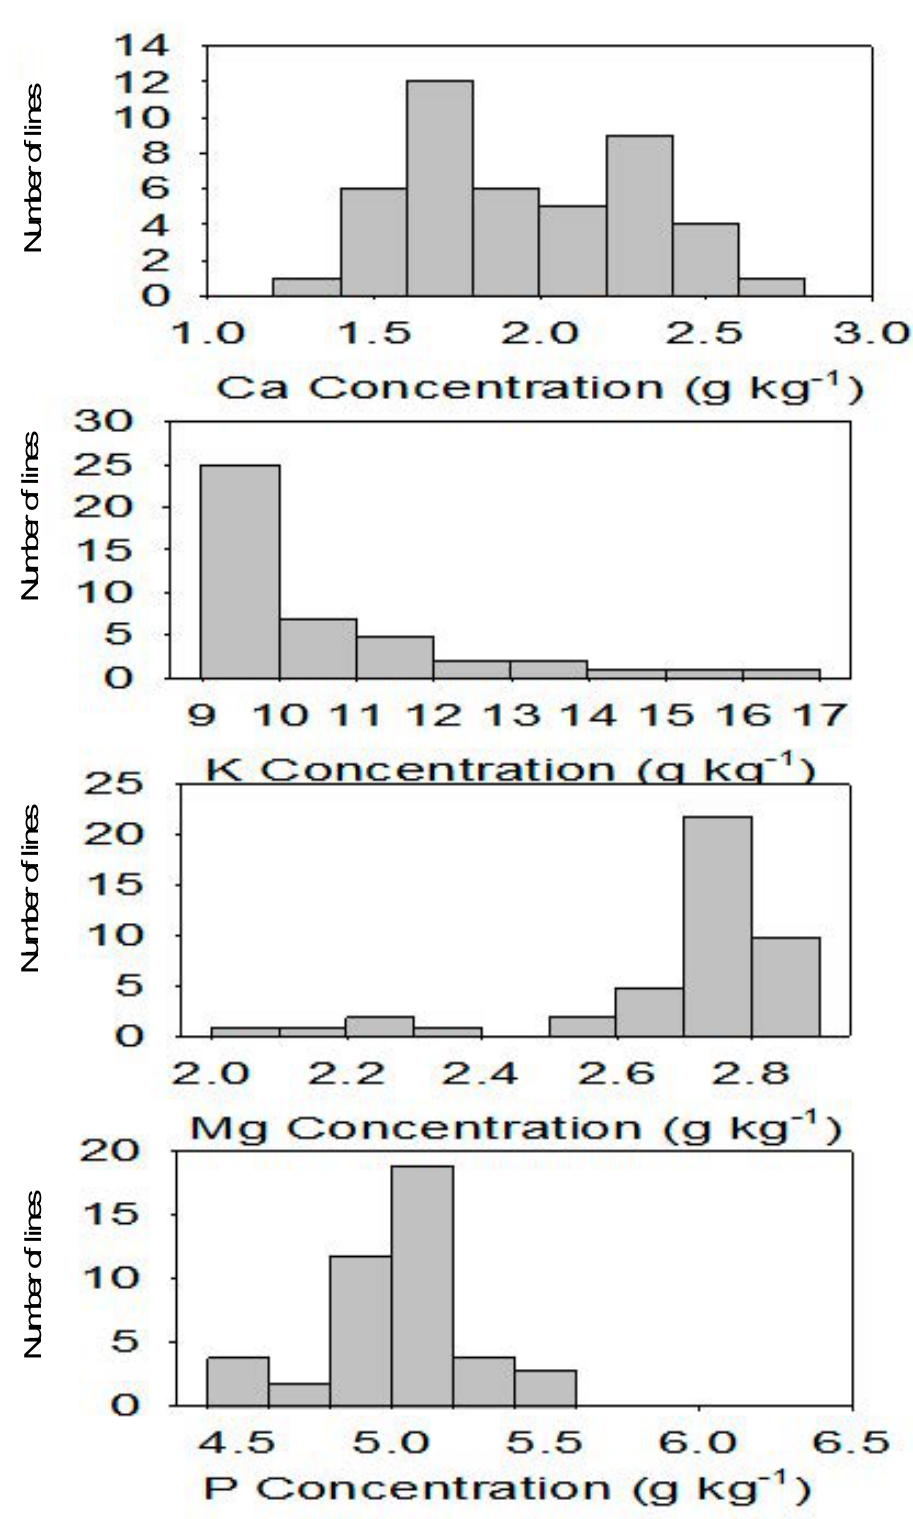
Figure 1. Distribution of macronutrients from top to bottom, respectively, for Ca, K, Mg, and P in cottonseed chromosome substitution lines (CS) across locations. X-axis is nutrient concentration; Y-axis is number of lines.